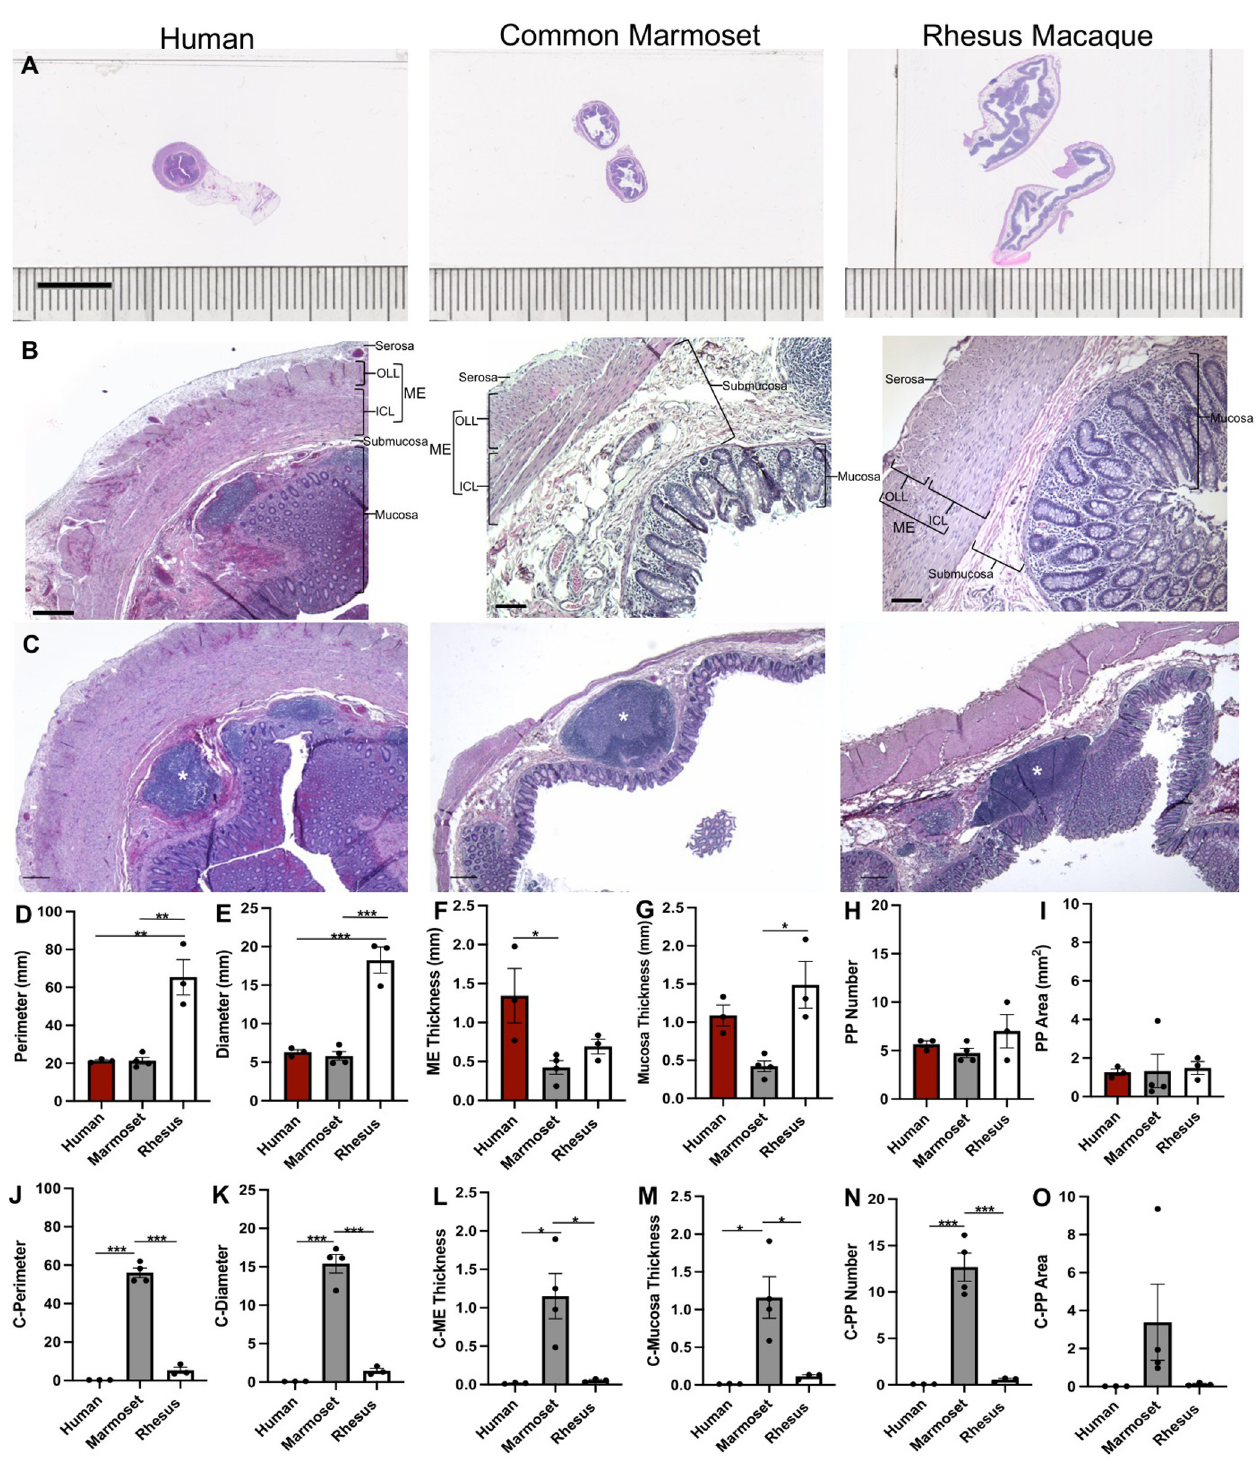
Fig 1. Organization and dimensions of the appendix/cecum across species. (A) Images of human appendix and common marmoset and rhesus macaque cecum tissue sections stained with H&E highlighting the difference in size across species, (B) anatomical regions and (C) Peyer’s patches (asterisk). Graphs (mean ± SEM) of the (D) perimeter and (E) diameter of the appendix/cecum, (F) muscularis externa thickness, (G) mucosa thickness, (H) number of Peyer’s patches and (I) area of Peyer’s patches across species. Graphs (J) to (O) correspond to the measures corrected by body size. Scale bar: a, 10mm; b, human, 500 μ m; rhesus and common marmoset 100 μ m; c, 500 μ m. Abbreviations: ME, Muscularis Externa; OLL, Outer Longitudinal Layer; ICL, Inner Circular Layer; PP, Peyer’s patch; C, corresponds to corrected measures by dividing value by subjects weight in kg. � p < 0.05, �� p < 0.01, ��� p < 0.001.